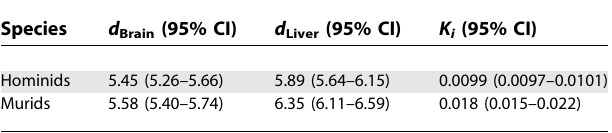
Table 4. Expression Divergence ( d ) and Intron Nucleotide Divergence outside CpG-Prone Sites ( K i ) for Hominids and Murids Species d Brain (95%